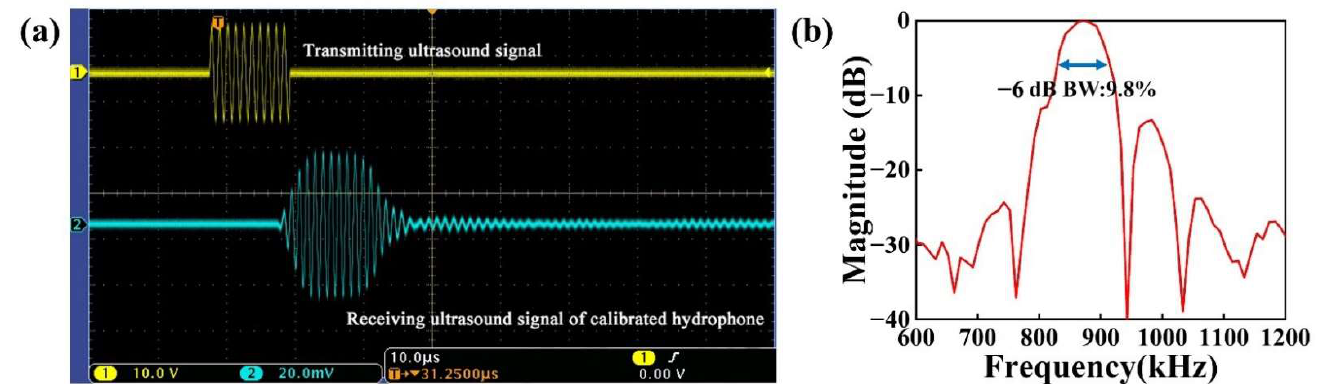
Figure 10. ( a )Measurement results of receiving sensitivity of a calibrated hydrophone; ( b ) the fre-